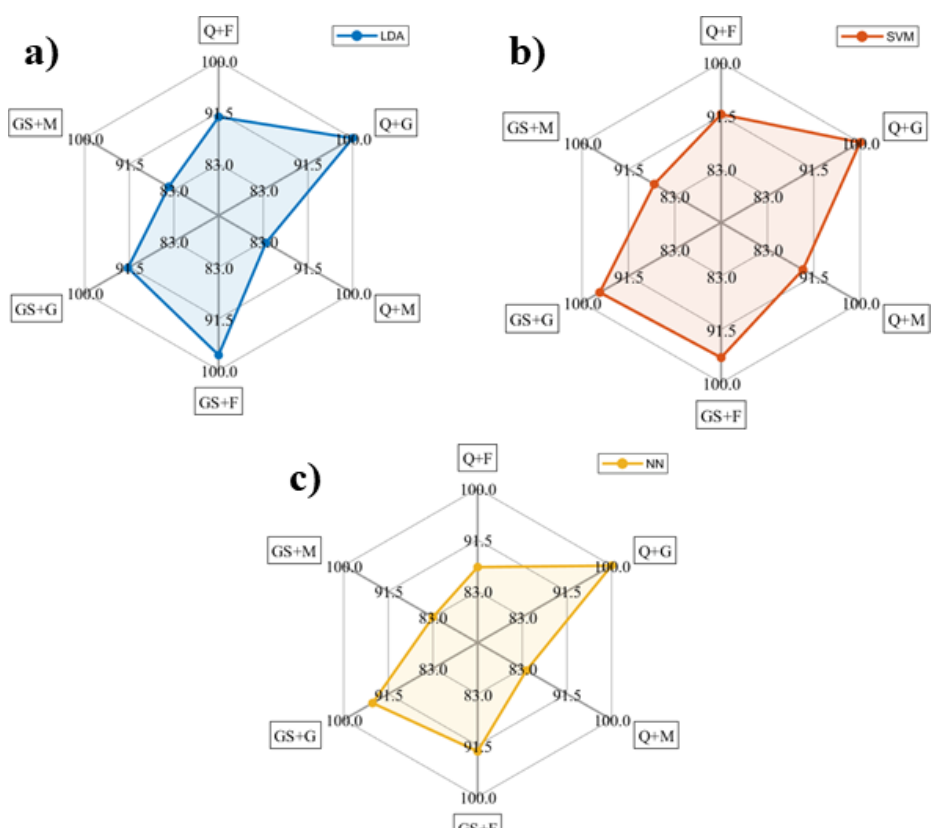
Figure 8. Training results. Comparison of the accuracy (validation) rate achieved by the different classifiers for each combination between Q and GS honey and F, G, M syrups. The results of classifiers LDA, SVM, and NN are represented in ( a – c ),